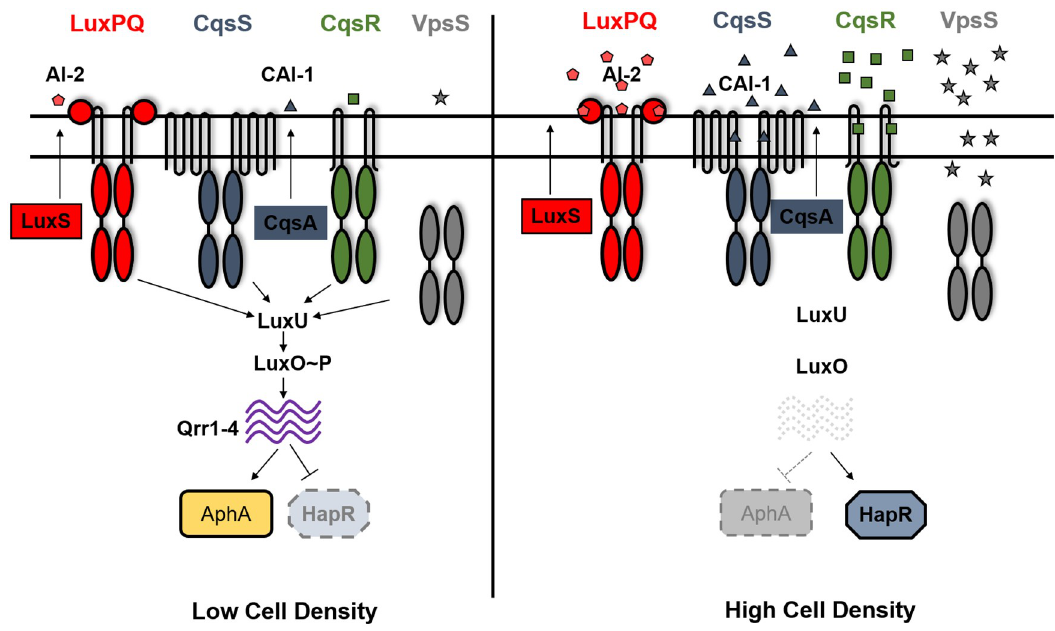
Fig 1. Quorum-sensing circuit in Vibrio cholerae . Quorum sensing in V. cholerae is controlled by four receptor histidine kinases CqsS, LuxPQ, CqsR and VpsS. At low cell density, these receptors act predominantly as kinases and phosphorylate LuxO through LuxU. Phosphorylated LuxO activates transcription of small RNAs Qrr1-4 which inhibit HapR translation and promote AphA translation, thereby resulting in a low cell density expression profile. At high cell density, when the cognate signals are bound, the kinase activity of these receptors is inhibited. This leads to dephosphorylation of LuxO, preventing Qrr1-4 transcription. Therefore, HapR translation is induced and AphA translation repressed, leading to a high cell density gene expression pattern. Autoinducers CAI-1 (produced by CqsA) and AI-2 (produced by LuxS) have been previously characterized in regulating the kinase activity of CqsS and LuxPQ respectively.